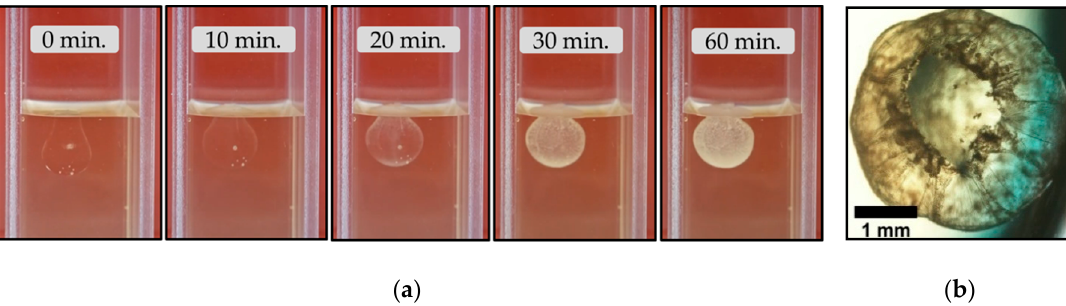
Figure 3. ( a ) Temporal evolution of morphology and texture of the calcium mineral vesicles (width of the cuvette is 1.25 cm); ( b ) hollow calcium vesicle with its opening.